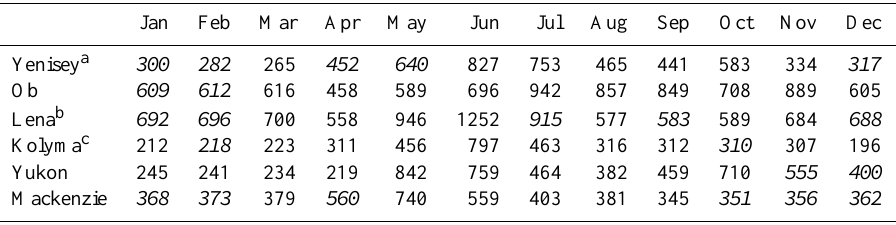
Table A5. Monthly-binned riverine concentrations of DOC (mmolCm − 3 ) . Linearly interpolated values are shown in italic. Jan Feb Mar